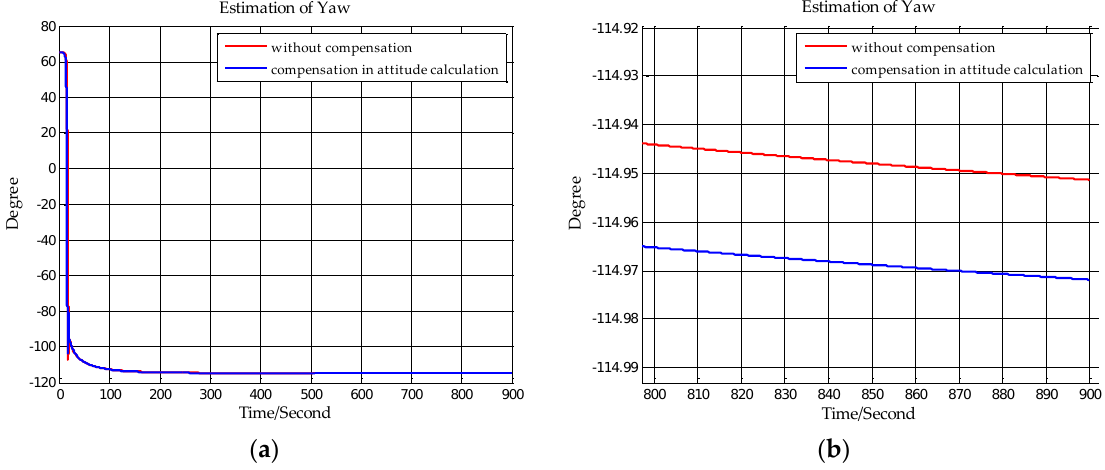
Figure 12. ( a ) is the estimation of yaw with compensation in attitude calculation, and ( b ) is the enlarged view of ( a ) in the last 100 s.